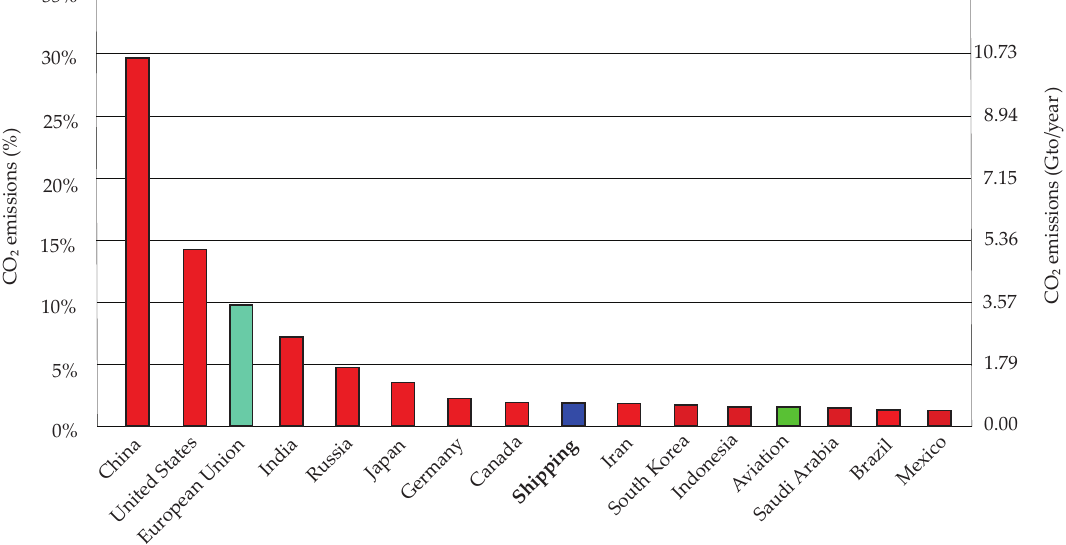
Figure 1. Global CO 2 emissions ranking according to the Emission Database for Global Atmospheric Research (EDGAR) report